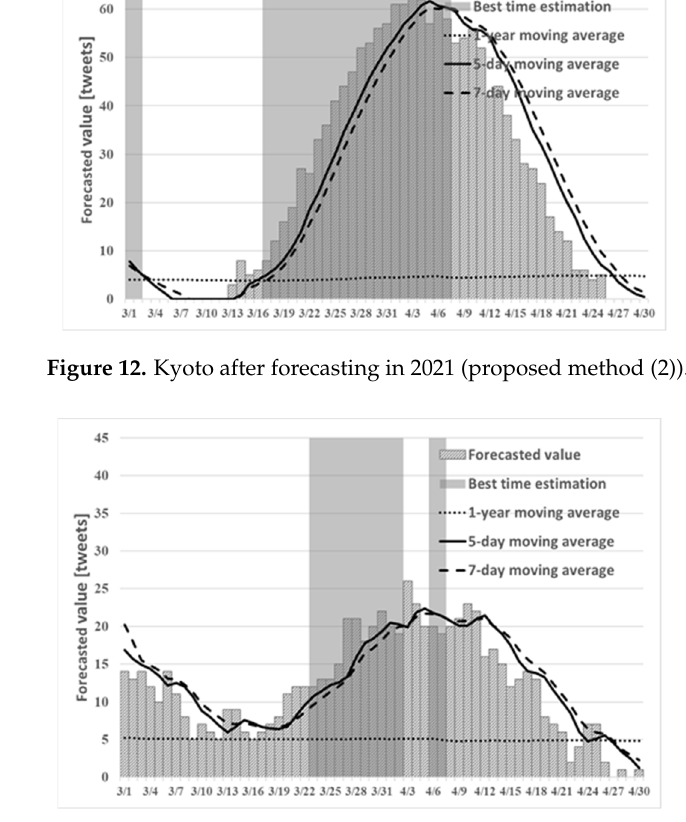
Figure 13. Shizuoka after the forecast in 2021 (proposed method (2)). Table 7. Number of tweets in 2021, actual total and the forecasted total (proposed method (2)). Area